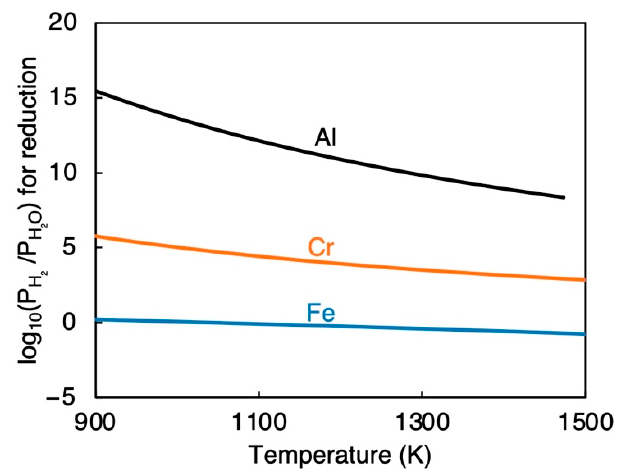
Figure 16. Simulated pH 2 /H 2 0 ratios for reducing Cr, Fe, and Al oxides as a function of temperature.